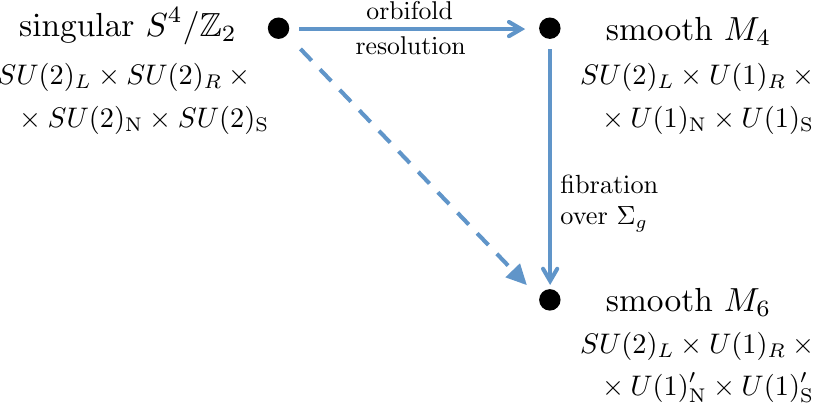
Figure 1 . Schematic representation of the geometric construction considered in this work. The starting point is a con(cid:12)guration with M5-branes extending in six non-compact directions. The angular transverse directions form the singular space S 4 = Z 2 . Along the horizontal arrow, the orbifold singularities of S 4 = Z 2 are blown up to yield a smooth manifold M 4 . The latter is then (cid:12)bered over a smooth Riemann surface (cid:6) g . For each stage of this process we give the corresponding global symmetries. The factors U(1) 0 (cid:2) U(1) 0 are de(cid:12)ned in (1.1). Finally, the diagonal dashed N S arrow corresponds to the expected RG (cid:13)ow across dimensions that results from wrapping the parent 6d (1,0) SCFT on (cid:6) g with the appropriate (cid:13)avor